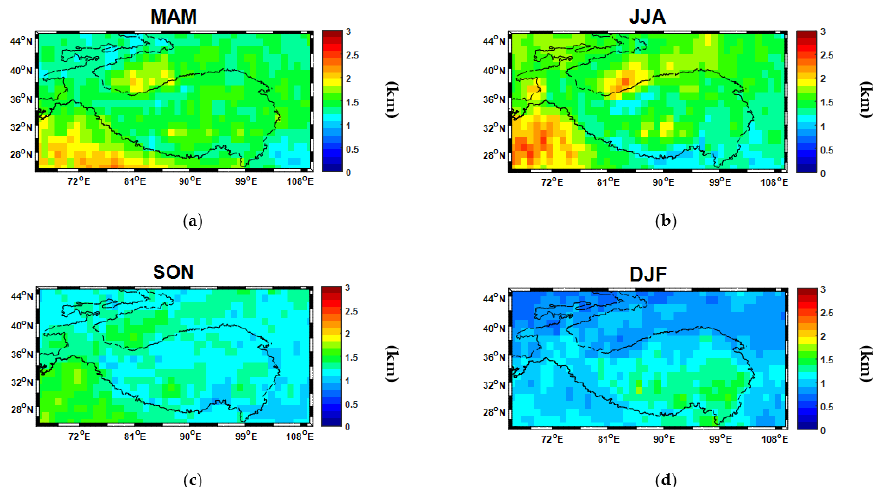
Figure 9. Seasonal maps of the lowest aerosol layer thickness (TL 1 ) over the TP: ( a ) spring, ( b ) summer, ( c ) fall, and ( d ) winter over the eight-year data period from January 2007 to December 2014 (The AOD is at 532 nm and the map is gridded at 1°).